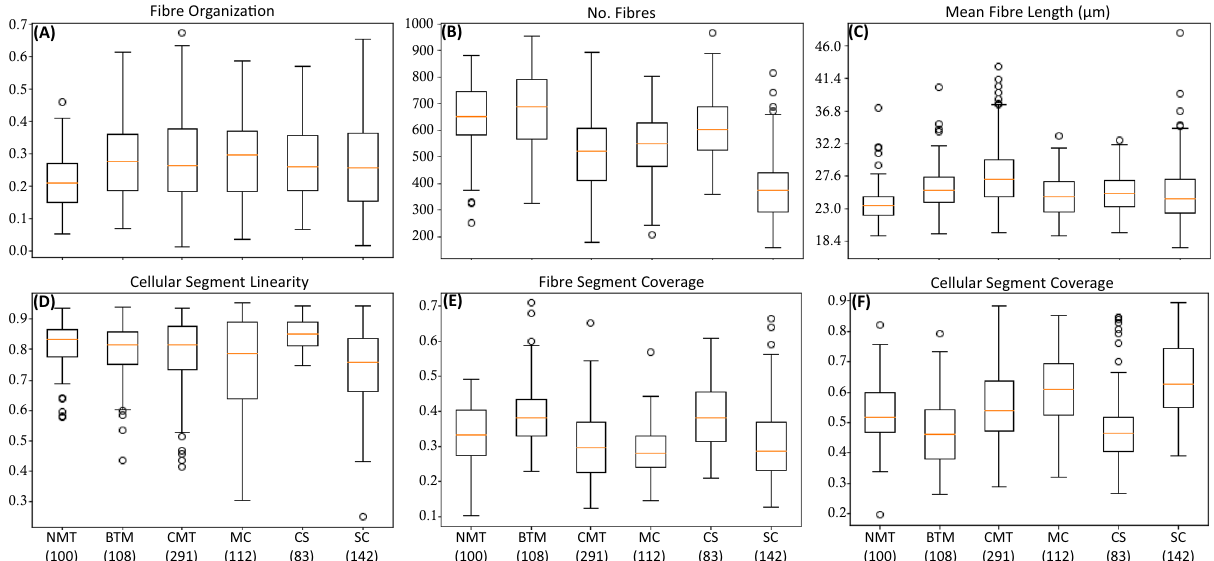
Figure 2. Boxplot graphics showing the calculated parameters for the fibre and cellular segments: the fibre organization, number of fibres, the mean fibre length, the cellular segment linearity and the image area covered by the fibre and cellular segments for all the tumour types studied. The numbers below each histological type indicate the number of acquired images. The centre lines show the medians, the box limits indicate the 25th and 75th percentiles, the whiskers extend 1.5 times the interquartile range from the 25th and 75th percentiles and the outliers are represented by